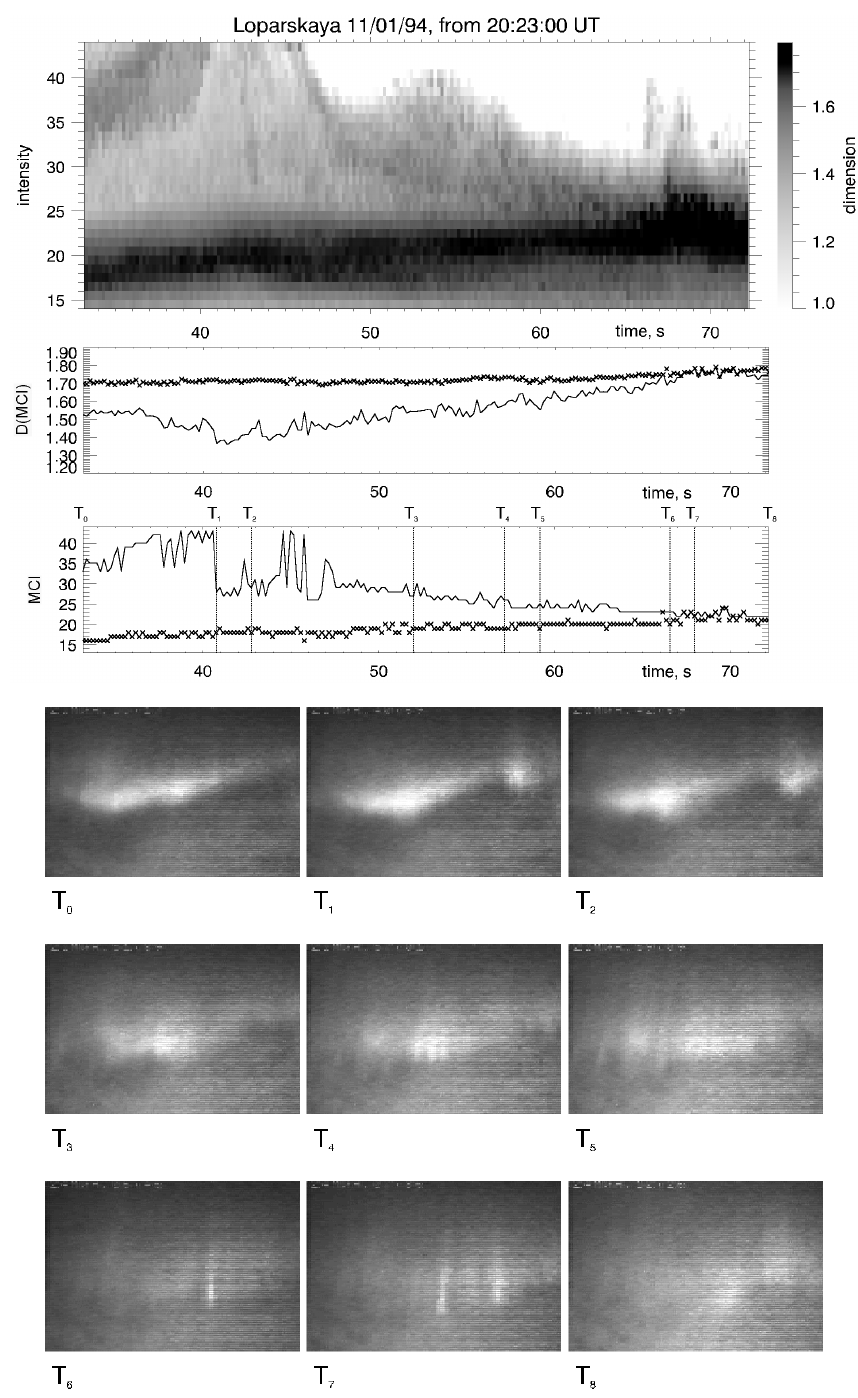
Fig. 13. The same as Fig. 12, but for event